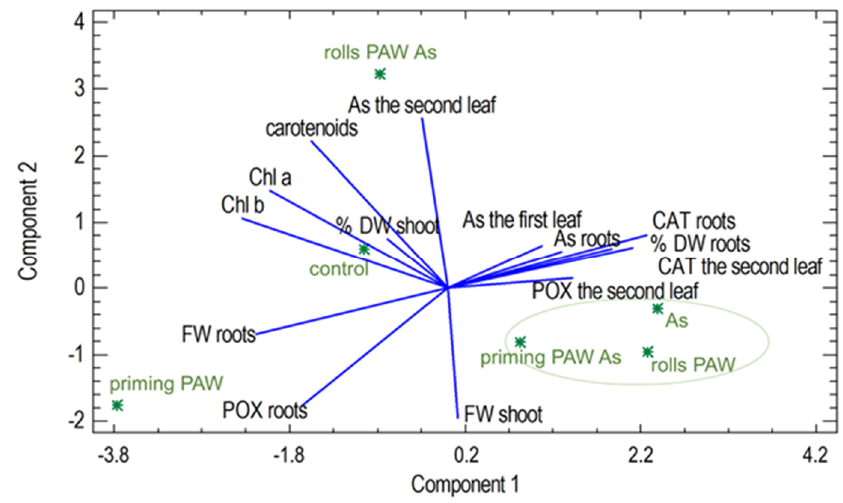
Figure 12. Biplot of the principal component analysis (PCA). The first two components extracted from the analysis together account for 61.2% of the variability in the original